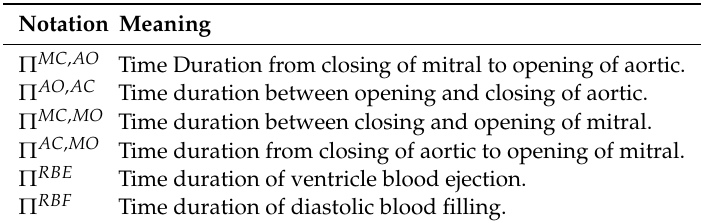
Table 2. Notation of SCG feature-variables.